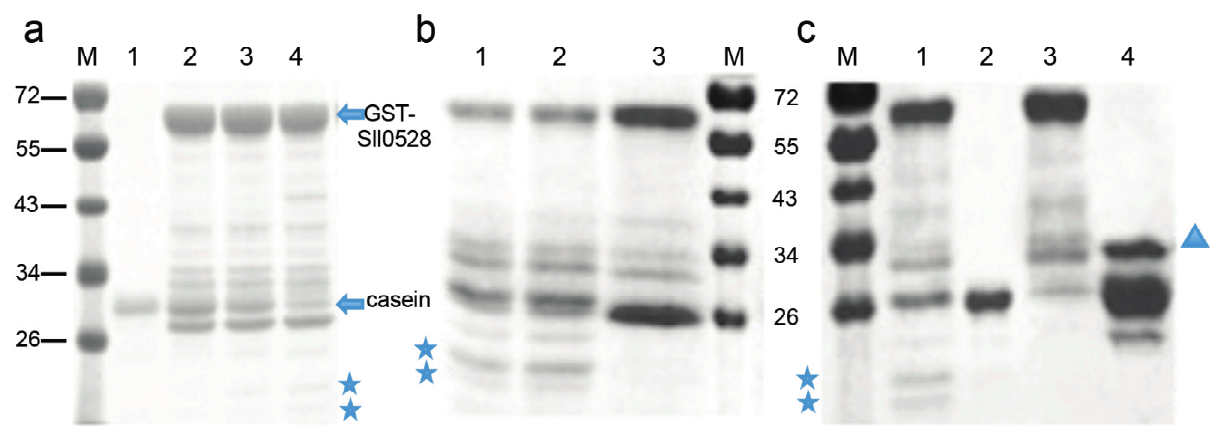
Figure 7. In vitro protease activity of recombinant Sll0528. ( a ) The time-dependent proteolytic activity of recombinant Sll0528. Lane 1, the substrate beta-casein remained intact in the reaction buffer after 15 h of incubation. Lane 2, reaction mixture of GST-Sll0528 and beta-casein prior to incubation. Lanes 3 and 4, incubated with GST-Sll0528 for 5 and 15 h, the substrate beta-casein was cleaved significantly. Stars indicated the cleaved fragments of beta-casein; ( b ) The inhibitor study. Lane 1, GST-Sll0528 cleaved beta-casein significantly after 15 h incubation. Lane 2, the proteolytic activity of Sll0528 was not inhibited by Complete EDTA-free (a cocktail of serine and cysteine protease inhibitors). Lane 3, the proteolytic activity of Sll0528 was inhibited by 10 mM o -phenanthroline; ( c ) The comparison of proteolytic activity to the recombinant protein P. Lane 1, GST-Sll0528 cleaved beta-casein significantly after 15 h incubation. Lane 2, the substrate beta-casein remained intact in the reaction buffer after 15 h of incubation. Lane 3, purified GST-Sll0528 in the reaction buffer after 15 h incubation. Lane 4, reaction mixture of beta-casein and GST-recombinant protein P (indicated by